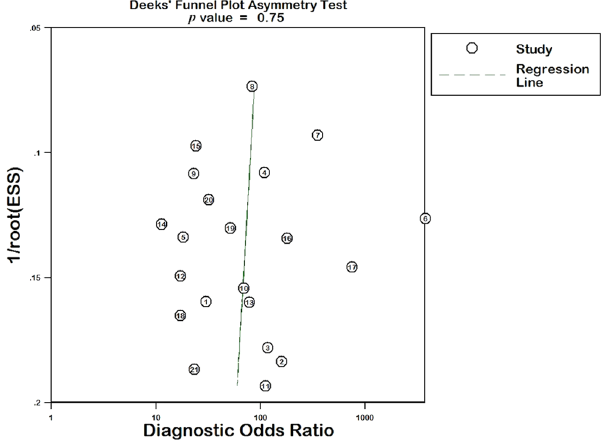
Figure 6. The Deeks’ funnel plot asymmetry test for publication bias in the literature evaluation. Each study is shown as a circle, and the regression line is